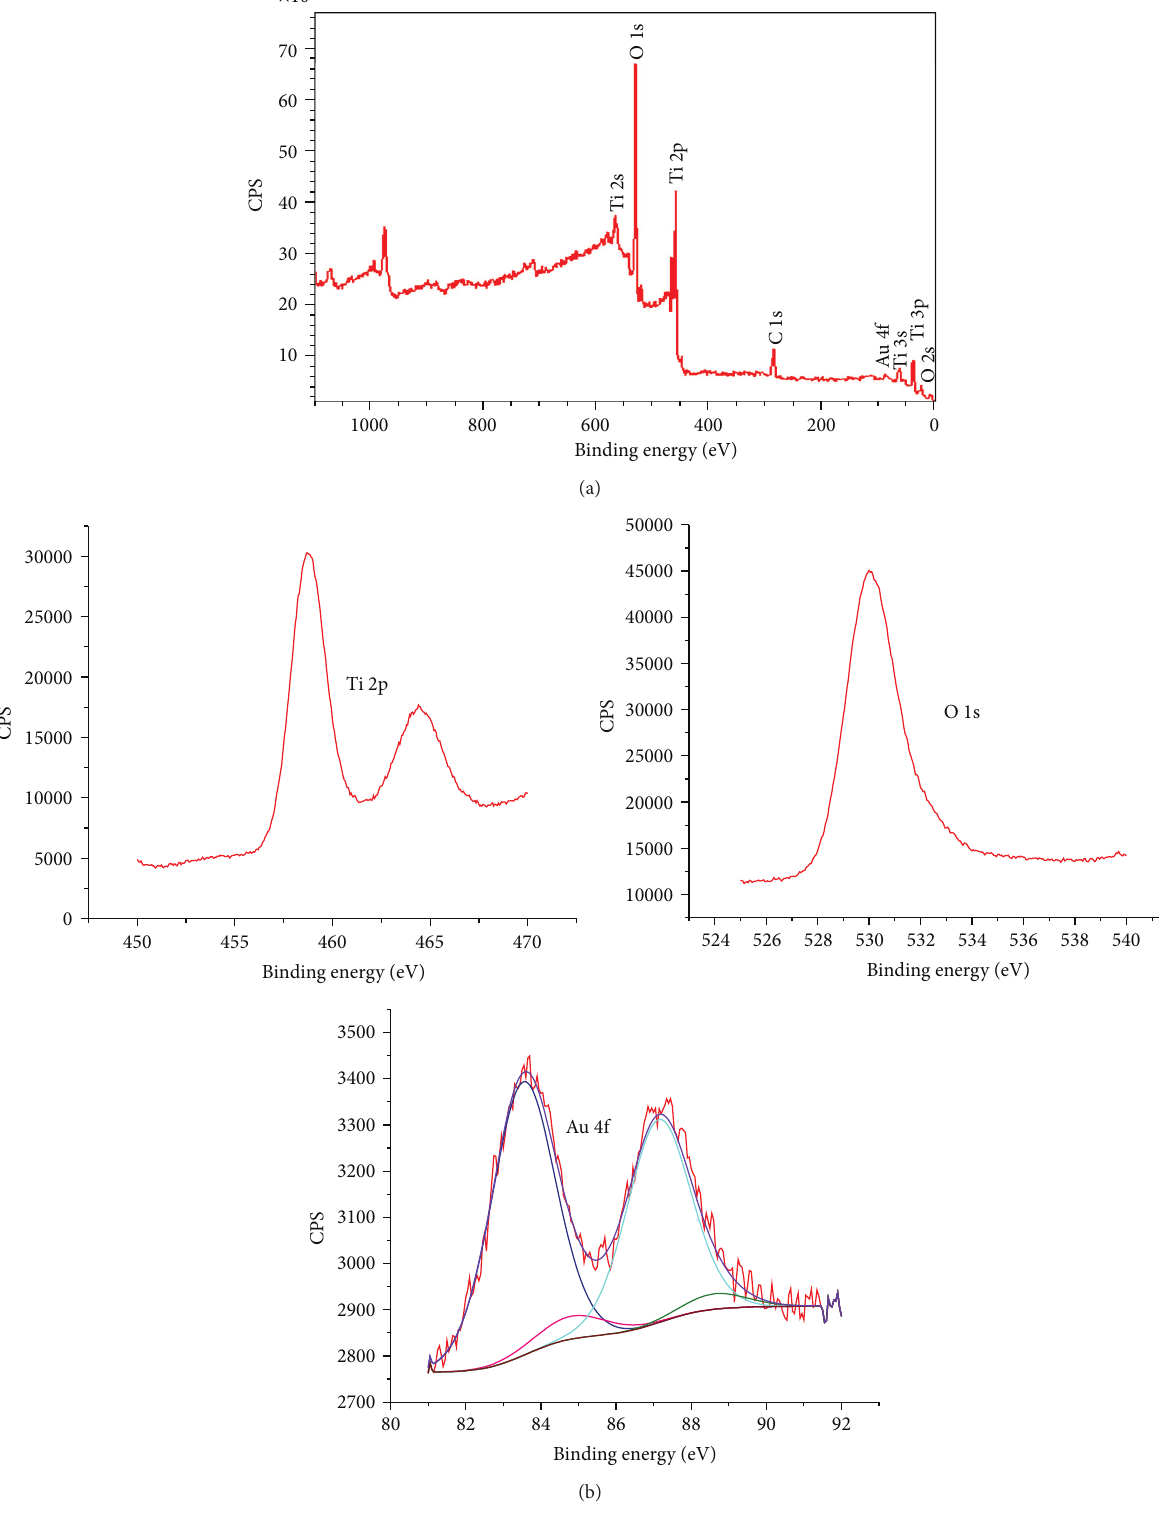
Figure 3: XPS spectra of 1.5%Au/TiO 2 : (a) wide scan spectra, (b) high resolution spectra corresponding to Ti 2p, O 1s, and Au